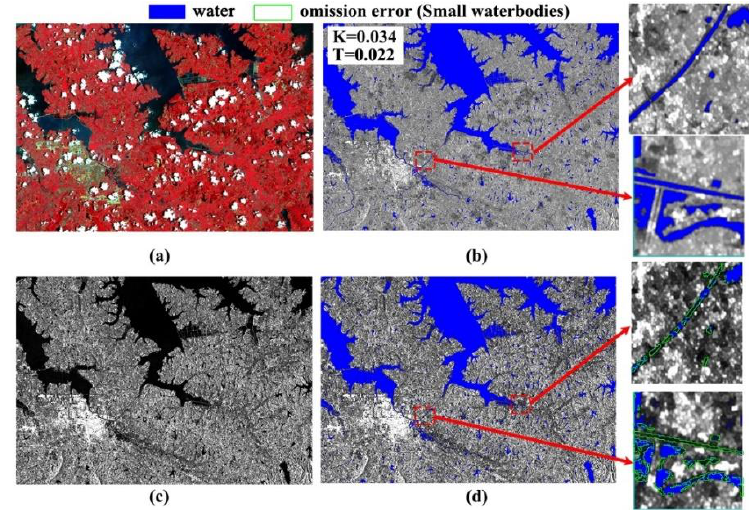
Figure 13. Waterbody extraction map for the Junshan Lake area: ( a ) Optical image. ( b ) Water extraction based on the SOWI. ( c ) SAR image. ( d ) Water extraction based on VV.